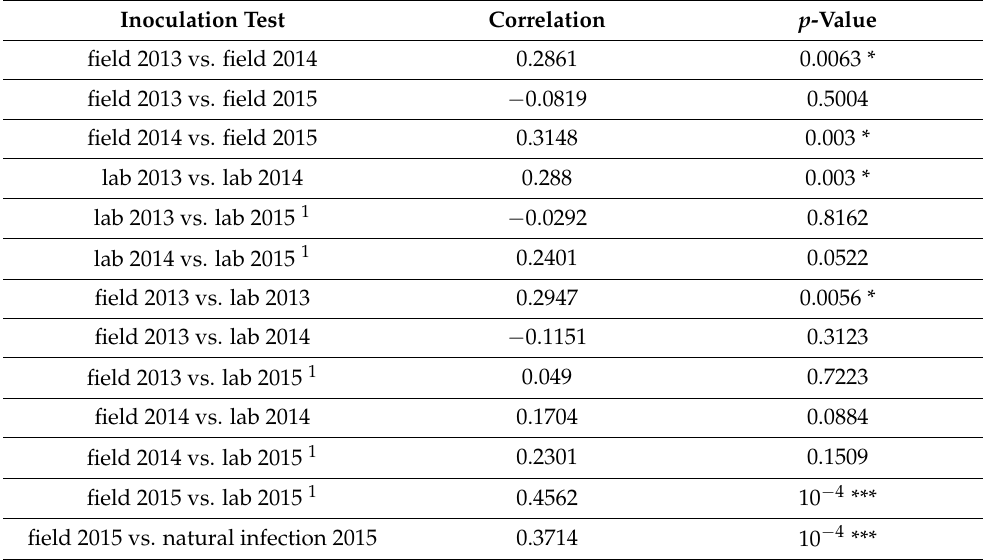
Table 3. Correlation of brown rot disease incidence between years and different tests: lab and field inoculations were performed using drop and spray, respectively. Inoculation Test Correlation p -Value field 2013 vs. field